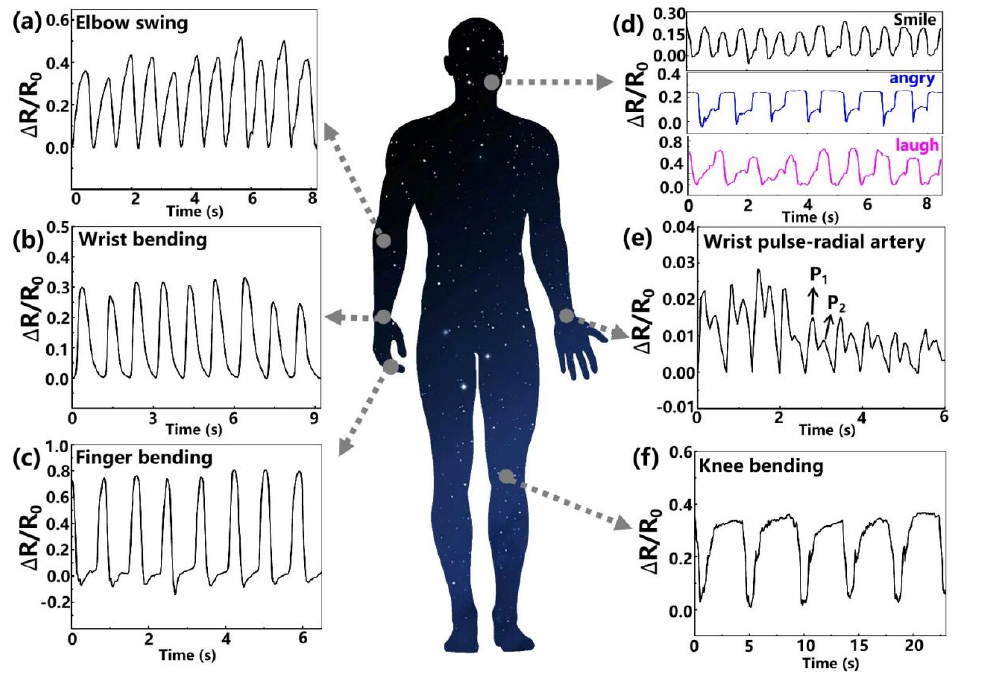
Figure 4. Applications of the MXene-based piezoresistive sensor for real-time monitoring of human activities. Resistance change waveforms of the wearable sensor in detecting human movements: ( a ) elbow swing, ( b ) wrist bending, ( c ) finger bending, ( d ) facial expressions, ( e ) wrist pulse, and ( f ) knee